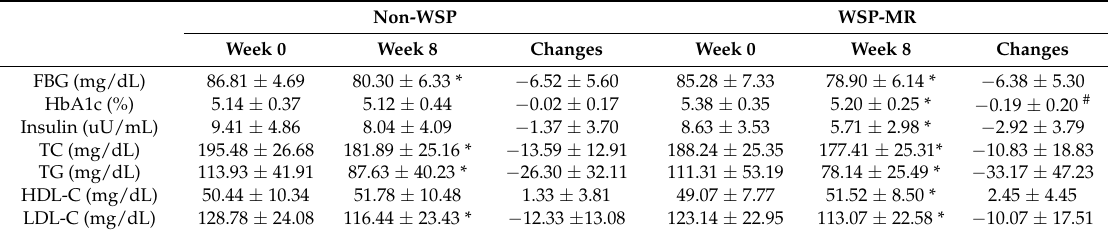
Table 5. Changes in participants’ glycemic markers and lipids profiles over weeks